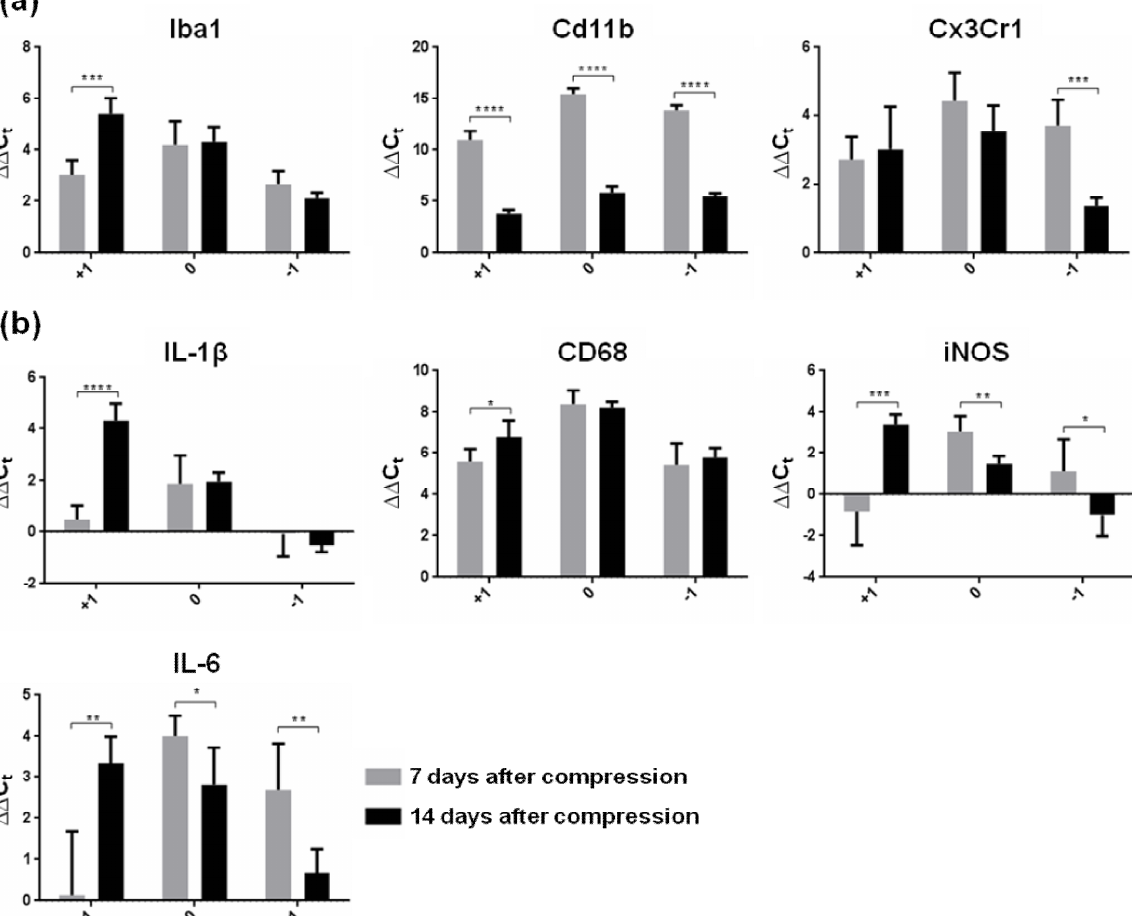
Figure 1. Gene expression of reactive microglial markers in spinal cord segments (0—lesion site, +1 cranially, − 1 caudally) one and two weeks after Th9 compression. ( a ) Microglia/macrophage markers (Iba1, Cd11b, Cx3Cr1), ( b ) markers representing M1 phenotype of reactive microglia showing inflammation (IL-1 β , CD68, IL-6) and oxidative stress (iNOS). Data are mean values of five experiments ± SD. The mRNA levels for each marker were normalized to the mRNA levels of 18sRNA and expressed as ∆∆ C t values relative to controls. Results were statistically evaluated using unpaired t -test; * p < 0.05; ** p < 0.01; *** p < 0.001; **** p < 0.0001. Iba1—ionized calcium-binding adaptor molecule 1; Cd11b—beta- integrin marker of microglia; Cx3Cr1—fractalkine receptor; IL-1 β —interleukin-1 β ; CD68—cluster of differentiation 68; iNOS—inducible nitric oxide synthase,